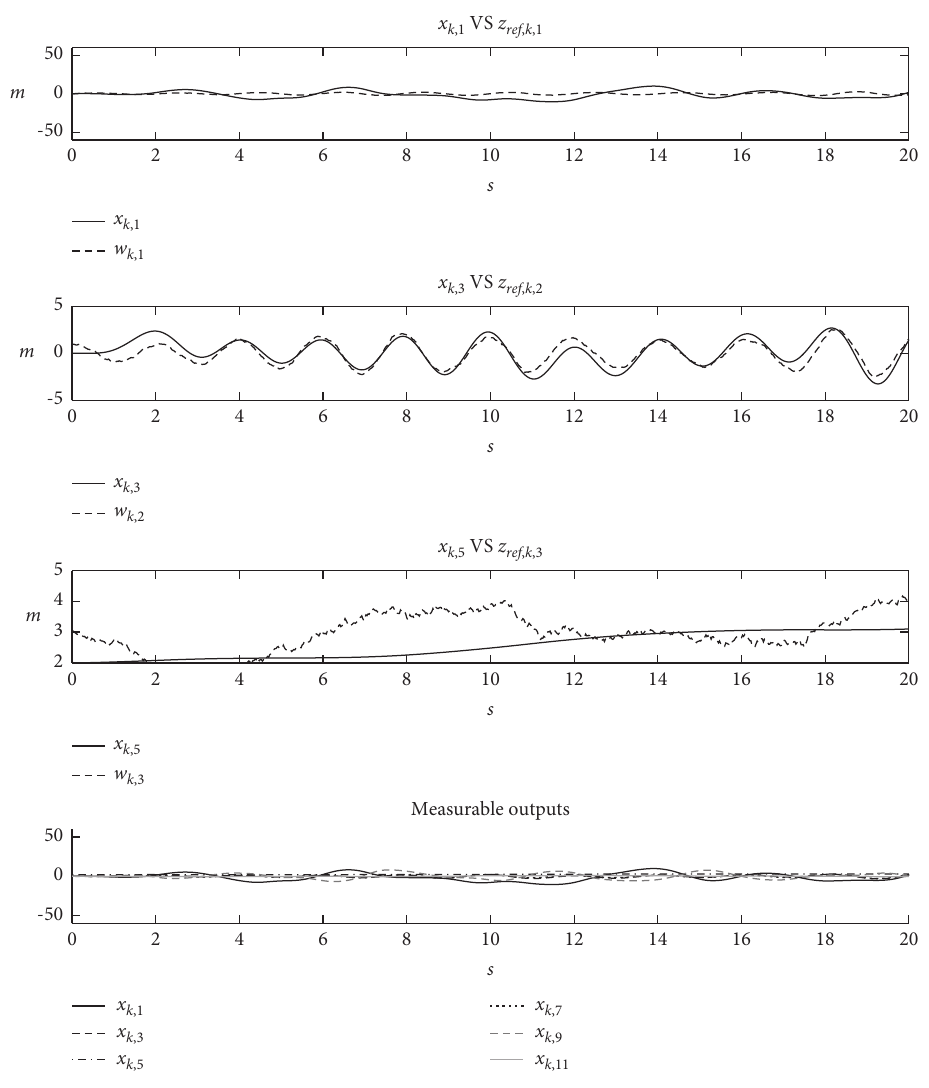
Figure 10: Tracking random references and available